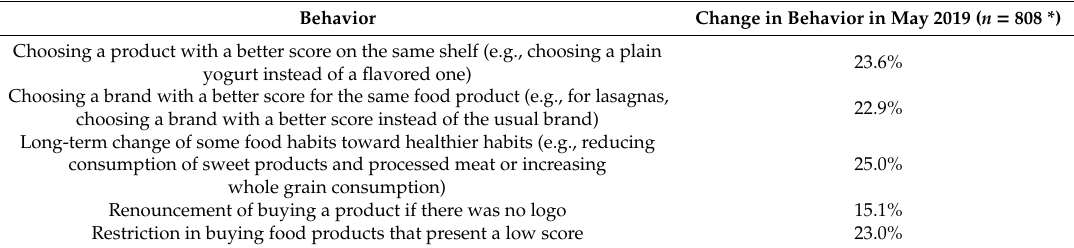
Table 3. Percentages of people declaring a change in purchasing behavior in May 2019.